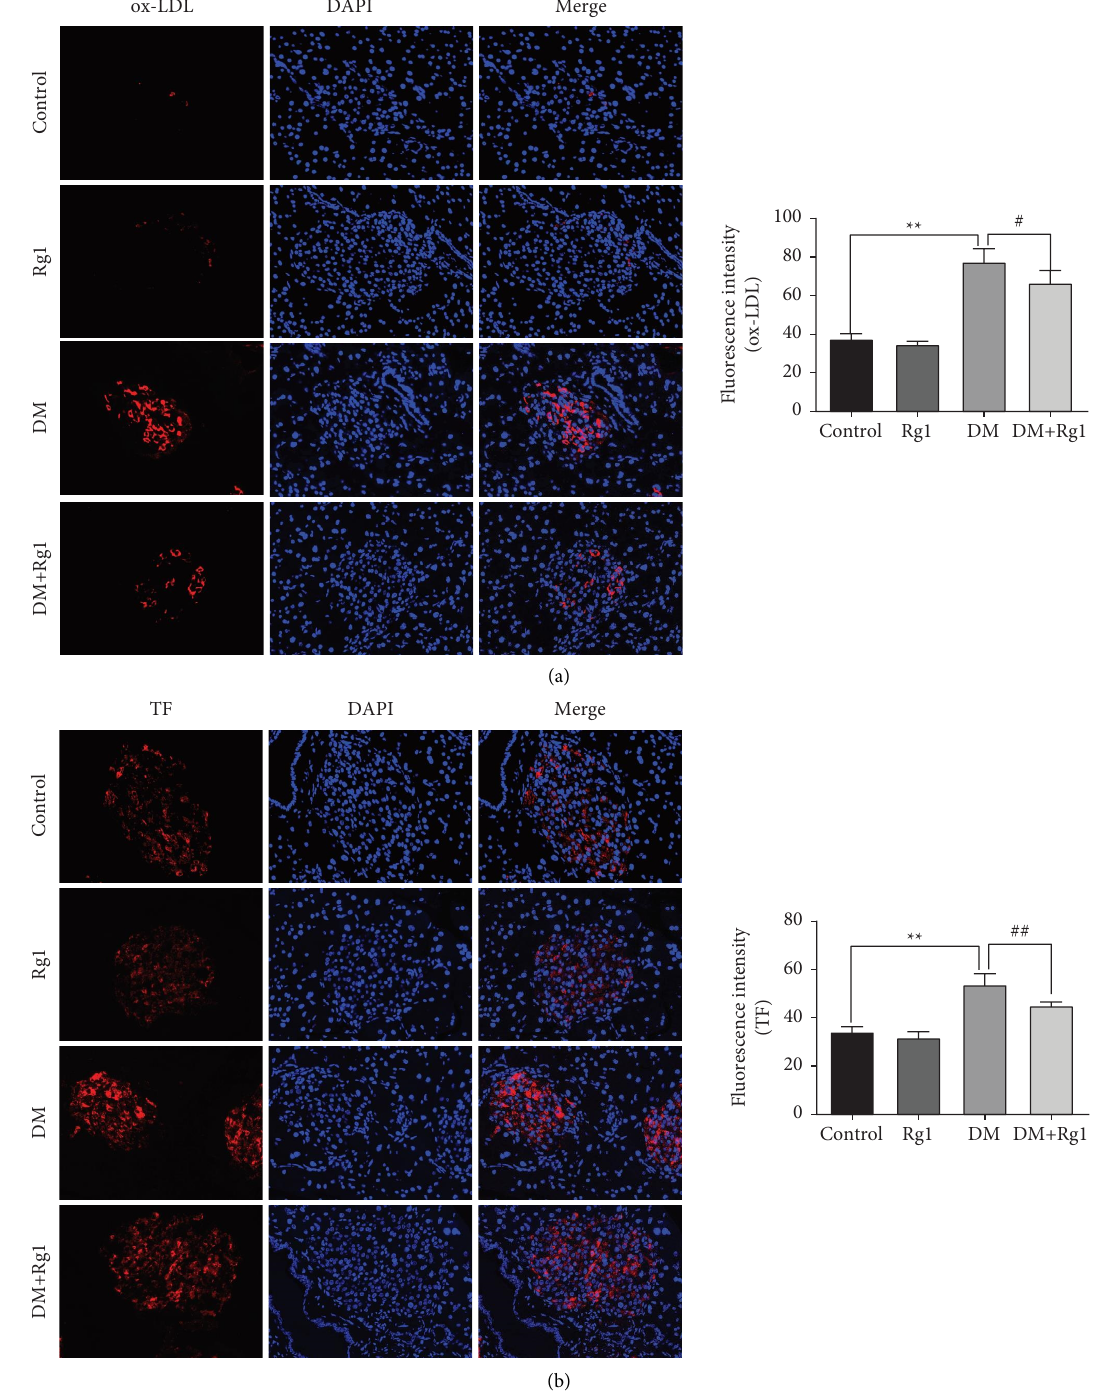
Figure 5: Te ox-LDL and TF proteins are expression in the pancreas through immunofuorescence. ( × 400, Scale: 50 μ m) (a) the expression of ox-LDL protein in the pancreas. (b) Te expression of TF protein in the pancreas. Te fuorescence intensity was detected to observe the protein expression. Tese results suggest the improvement of Rg1 on the pancreas of type 1 diabetes mice may be by inhibiting the ox-LDL and TF levels. (Mean ± SD, n � 6) ∗∗ p < 0 . 01, vs. the control group; # p < 0 . 05, ## p < 0 . 01 vs. the DM